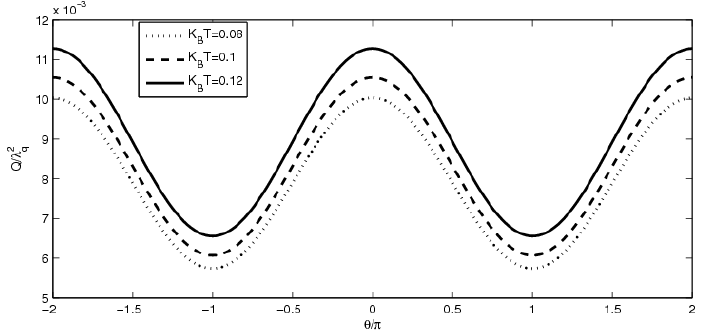
Figure 4. The heat generation Q versus polarization angle θ . The parameters are chosen as eV = 2.5 Δ , eV g =